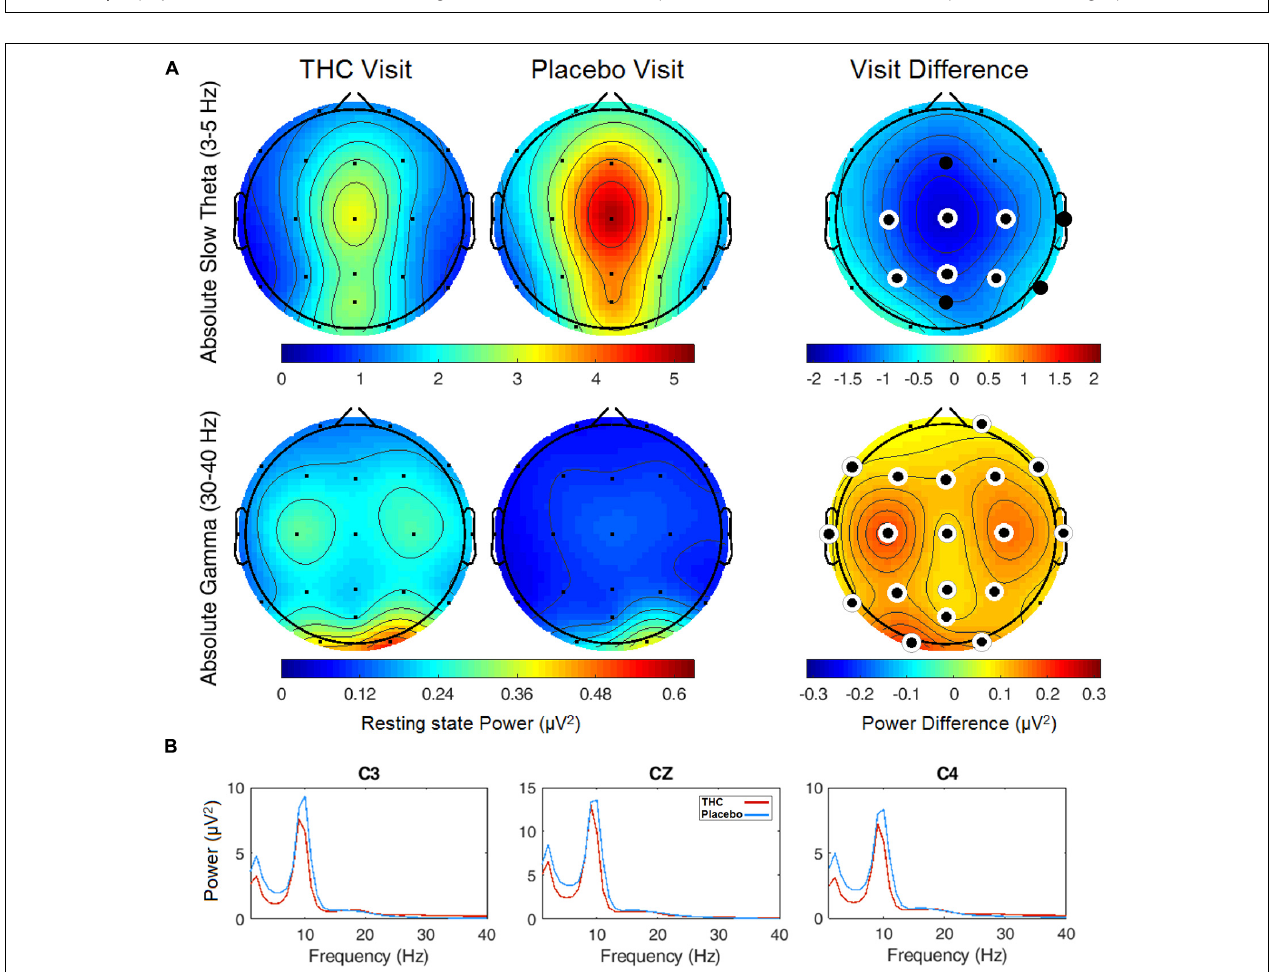
FIGURE 2 | Resting state eyes closed by visit. THC visit associated with spectral power decreases at slow frequencies and increases at fast frequencies. (A) Topographic maps where significant differences after FDR correction for multiple comparisons are marked with white rings. Visit differences at slow Theta were significant across central and parietal channels (top row). Gamma band spectral power were greater in all channels but Fp1 and T6 for subjects during their THC visit (bottom row). (B) Power spectral densities at central channels. THC visit, red line; Placebo visit, blue line.